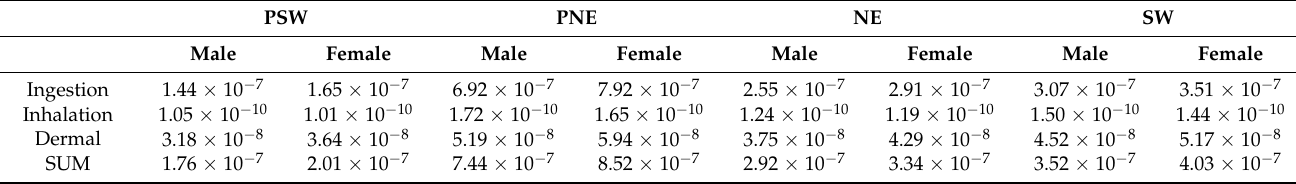
Table 3. ILCRs for three exposure routes in four seasons from 2020 to 2021 in Singapore.